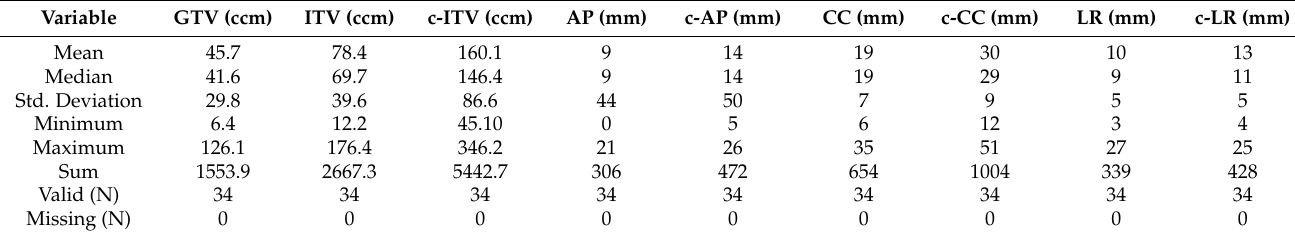
Table 1. Descriptive statistics.